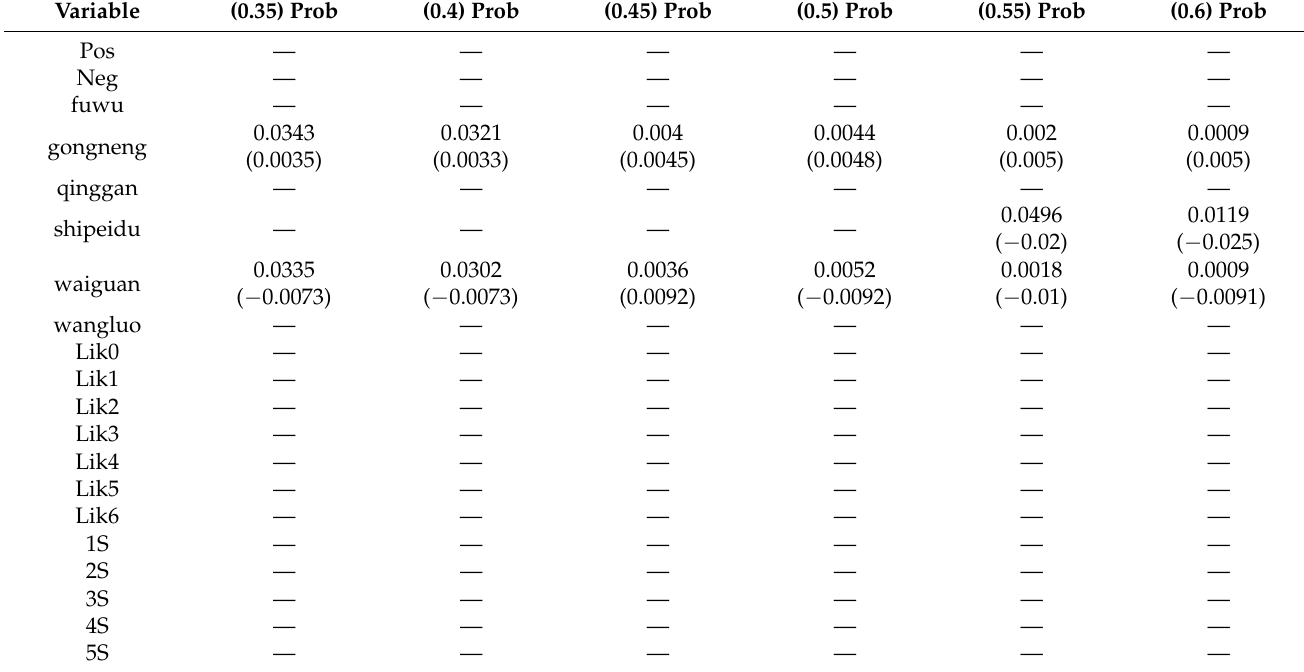
Table 15. Variables significant at 0.35 to 0.6